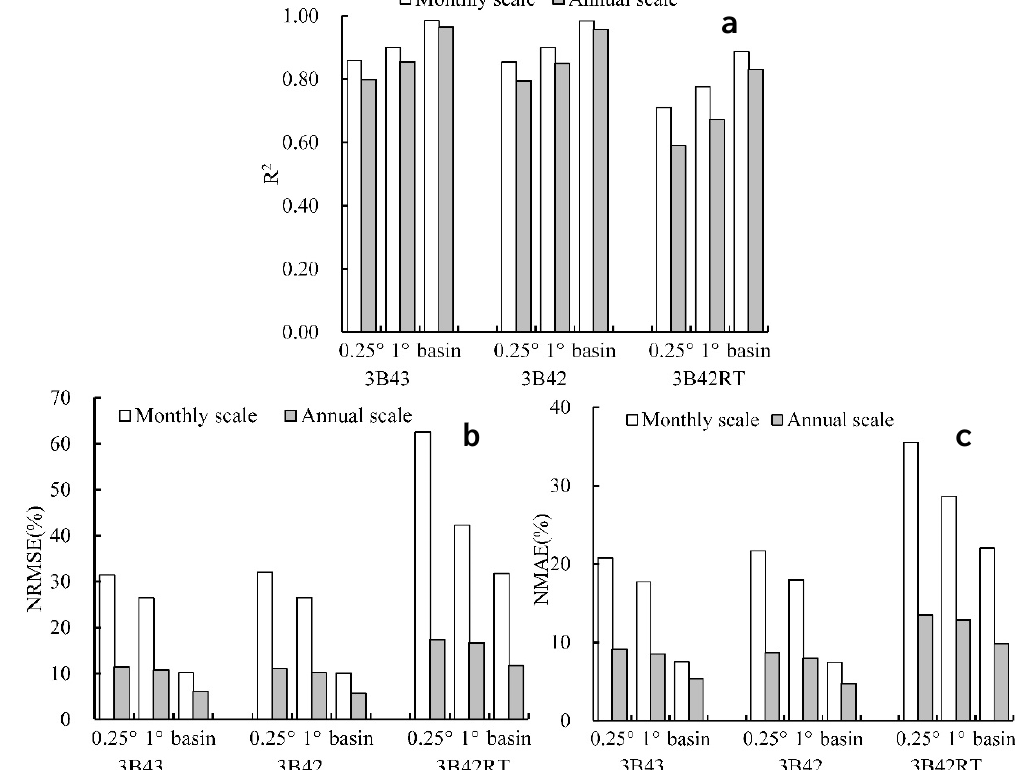
Figure 5. Comparison of validation indices for TRMM 3B43, 3B42 and 3B42RT at different spatial scale, with ( a ) for R 2 ; ( b ) for normalized root mean squared error (NRMSE); ( c ) for normalized mean absolute error (NMAE).